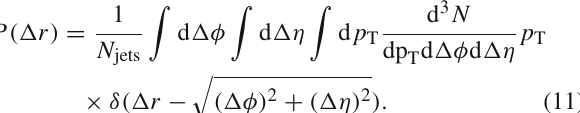
In practice, P ((cid:2) r ) is just the distribution of charged parti- cles in the annular rings around the jet axis with each par- ticle weighted by its transverse momentum, see Eq. (2). In Fig. 7, we show jet transverse momentum profile P ((cid:2) r ) in p + p collisions (top left panel) and Pb + Pb collisions (mid- dle panels). The Pb + Pb results are shown for four cen- tralities: 0 − 10% , 10 − 30% , 30 − 50%, and 50 − 100%. The stacked histograms are results from the AMPT model: dif- ferent colors represent the contributions from different p T intervals for charged particles. The accumulated histogram is for 0 . 7 < p T < 20 GeV. The bottom panels show the ratio between Pb + Pb and p + p collisions for different p T intervals, 4 − 300 GeV, 2 − 300 GeV and 0 . 7 − 300 GeV. From Fig. 7, one observes a large excess of soft particles together with a depletion of hard particles in Pb + Pb colli- sions relative to p + p collisions. The enhancement of soft particles is more prominent at large (cid:2) r region. This means that the energy is transported from hard jets to soft particles at large (cid:2) r regions away from jet axis. Such effect is stronger in central collisions than in peripheral collisions. We also see that our AMPT model calculations overestimate the accumu- lated transverse momentum profile at large (cid:2) r region, which may be due to the negligence of inelastic radiative process in the parton